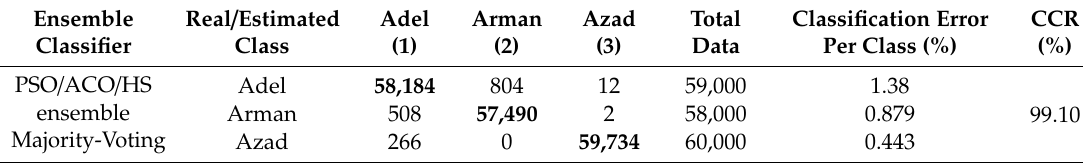
Table 8. Confusion matrix including correct classification rate (CCR) for ensemble ANN Majority-Voting (MV): Adel, Arman and Azad chickpea ( Cicer arietinum L.) varieties (1000 uniform random iterations, test